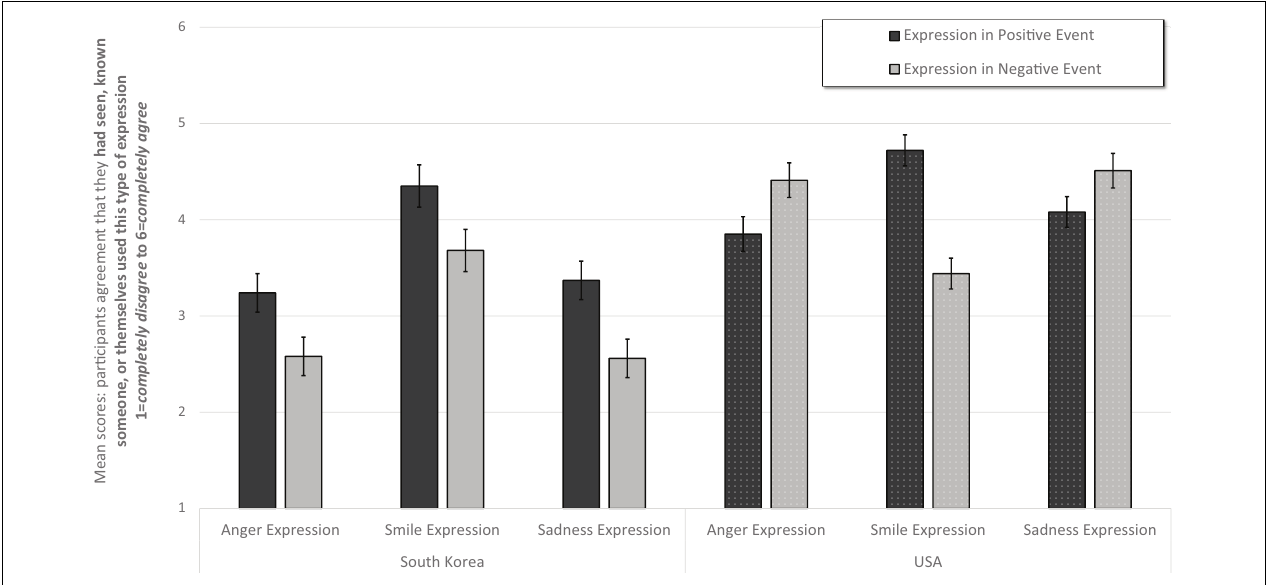
FIGURE 6 | Figure illustrates the prevalence of anger, sadness or smiling expression in positive and negative events. Error bars indicate ± 2 standard errors.